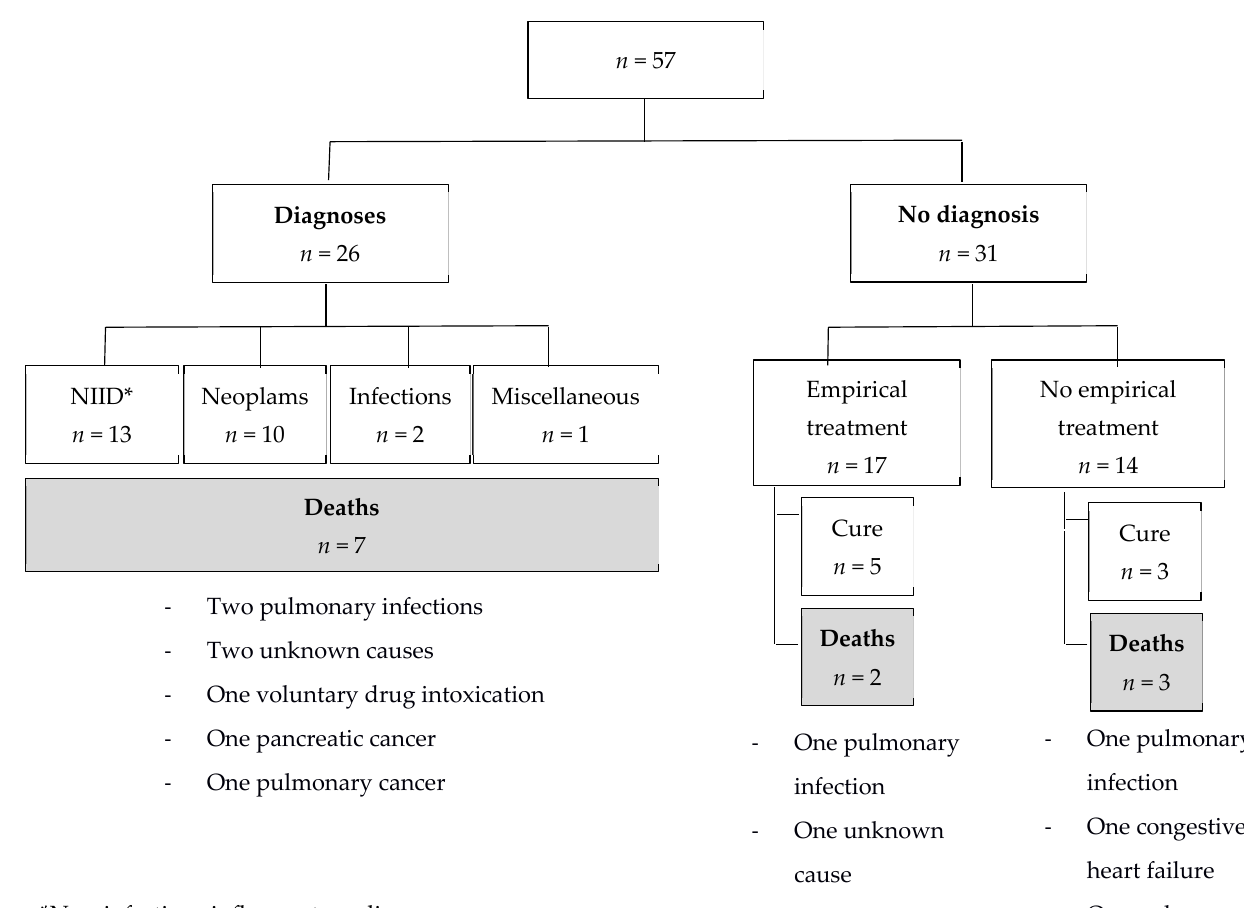
Figure 2. Death repartition according to diagnoses and empirical treatment.